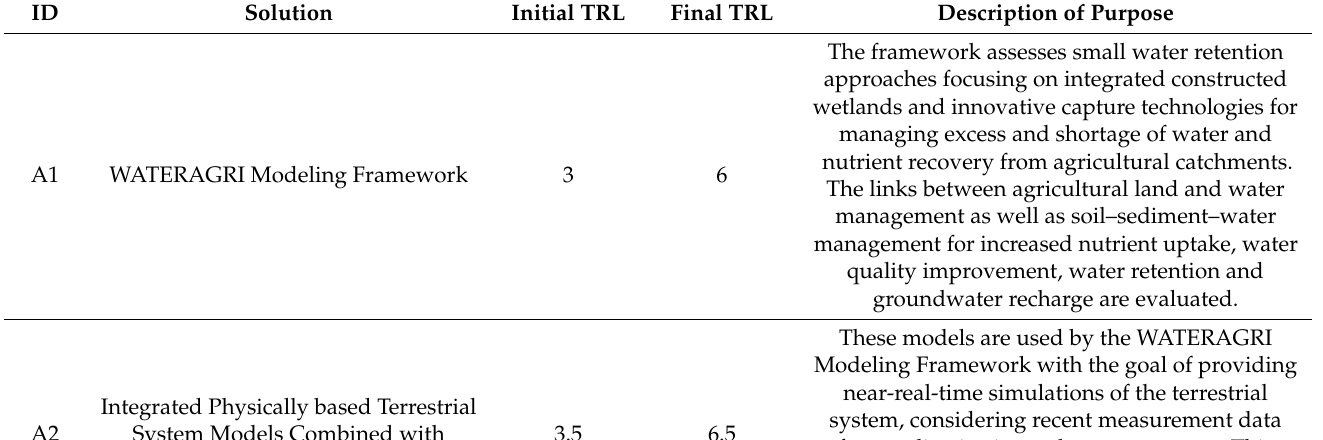
Table 1. Purpose of selected WATERAGRI solutions within the modeling framework and their corresponding technology readiness levels